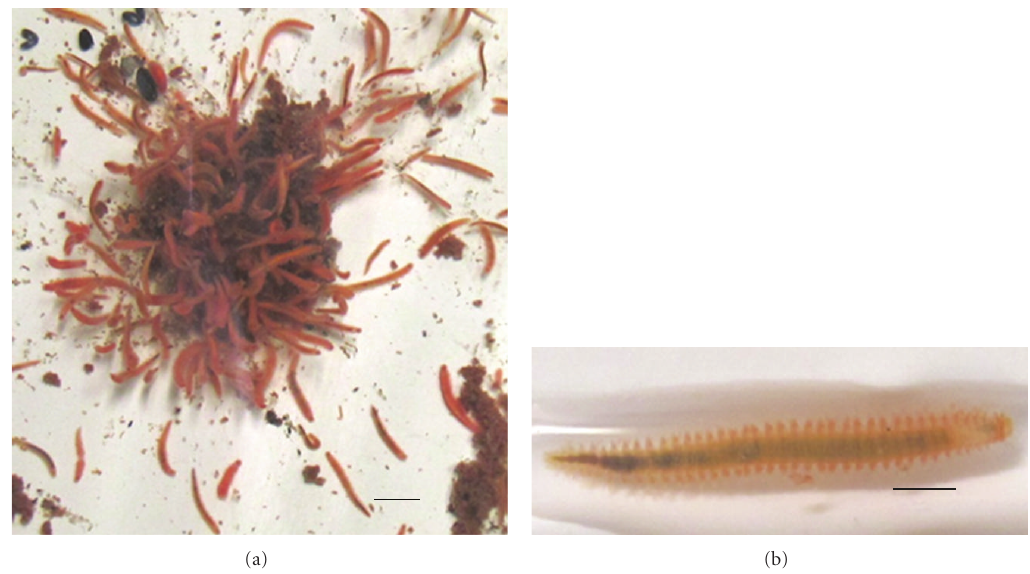
Figure 1: General appearance and size of polychaetes ( Ophyrotrocha sp.) from salmonid aquaculture sites located on the south coast of Newfoundland. (a) Congregation of worms in mucus complex around food pellet in the laboratory tanks (scale bar = 8 mm). (b) Worm showing upper size range of individuals (approx. 16 mm) (scale bar =